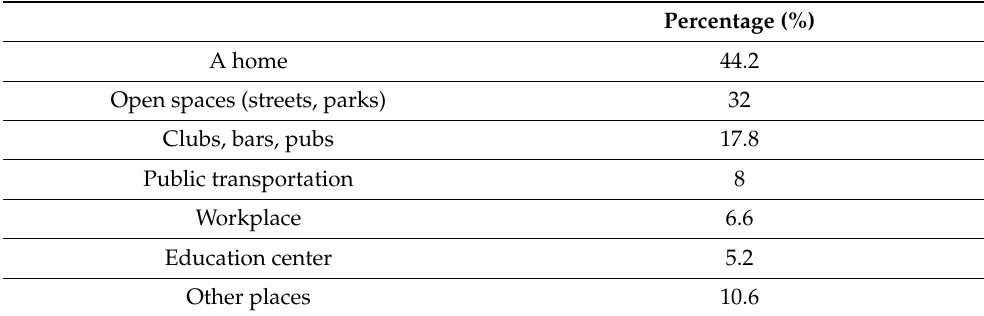
of violence outside a couple relationship (%).